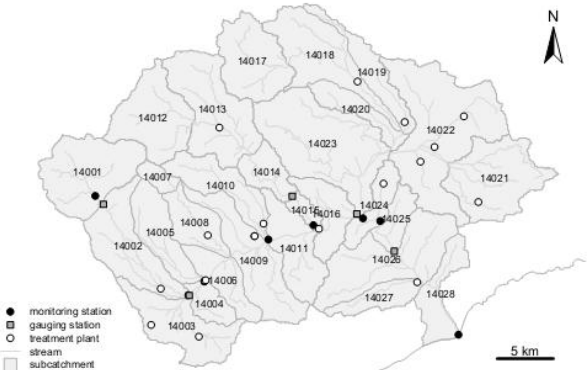
Fig. 3. Representation of the catchment and subcatchment borders with their labels in La Tordera catchment, and the river network with the location of waste water treatment plants (WWTPs) and monitor- ing and gauging stations used for the calibration. Source: original, based on data from ICC and Catalan Water Agency (ACA, Agencia Catalana de